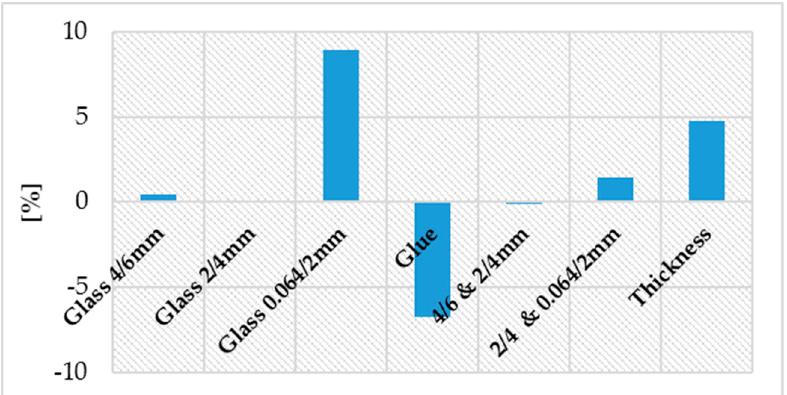
Figure 5. Influence of each mix-design variable on the power loss.